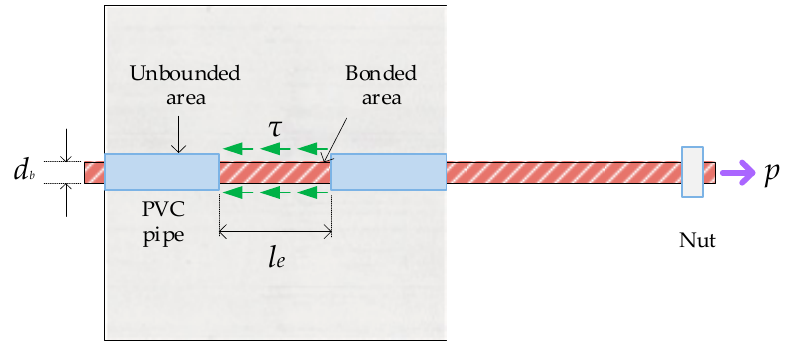
Figure 5. Schematic diagram of local bond stress between the bar and concrete.